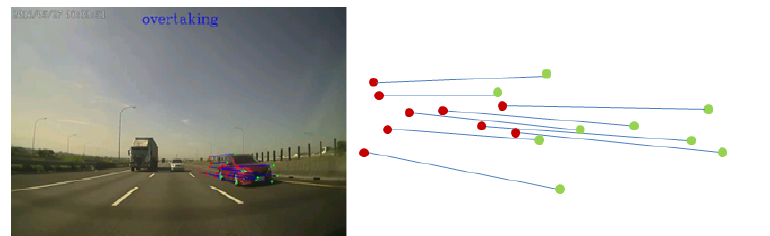
Figure 9. Only the optical flow in the x -direction is used to distinguish the overtaking vehicle from the object moving further